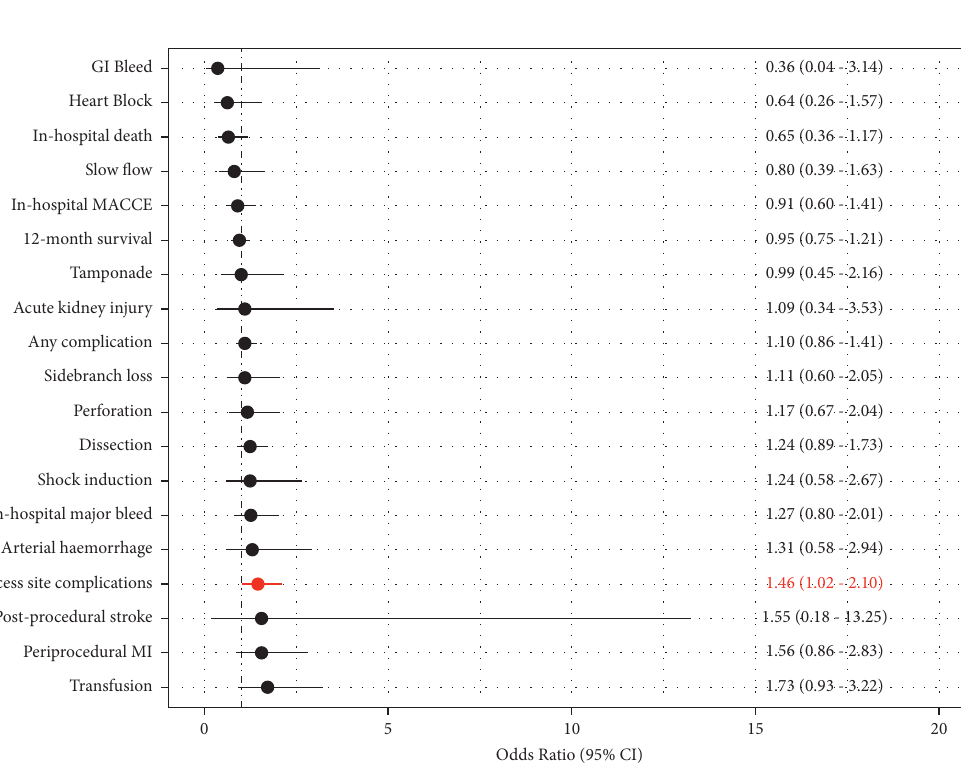
Figure 3: Adjusted outcomes by intracoronary imaging use in patients undergoing RA-PCI in England and Wales, 2007 − 2014. CI: confidence interval; MACCE: major adverse cardiac and cerebrovascular